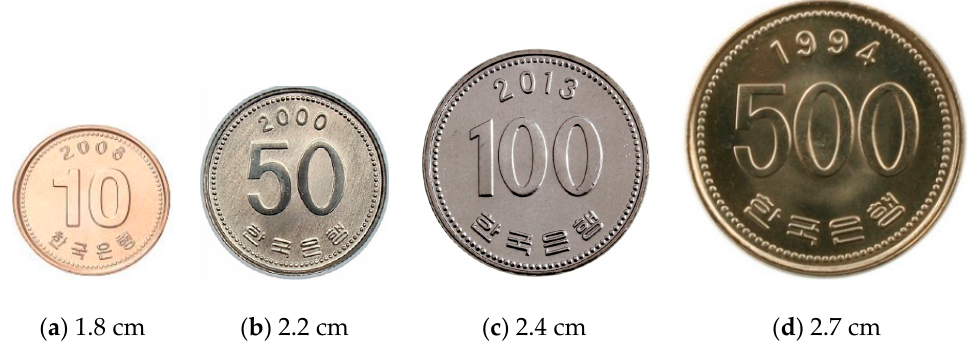
Figure 1. Examples of four coins of different sizes (diameter 1.8–2.7 cm) displayed in the questionnaire to assess the amounts of applied product (pen